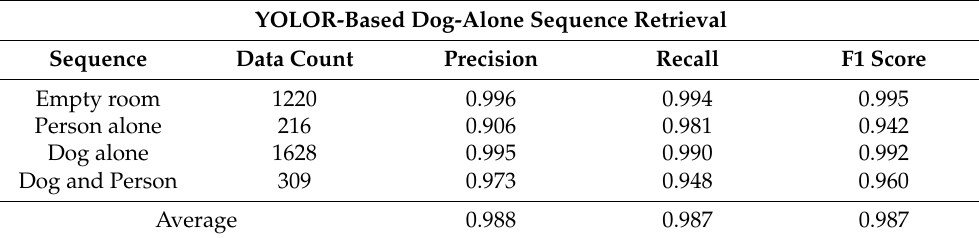
Table 5. YOLOR-based dog sequence retrieval performance using precision, recall and F1